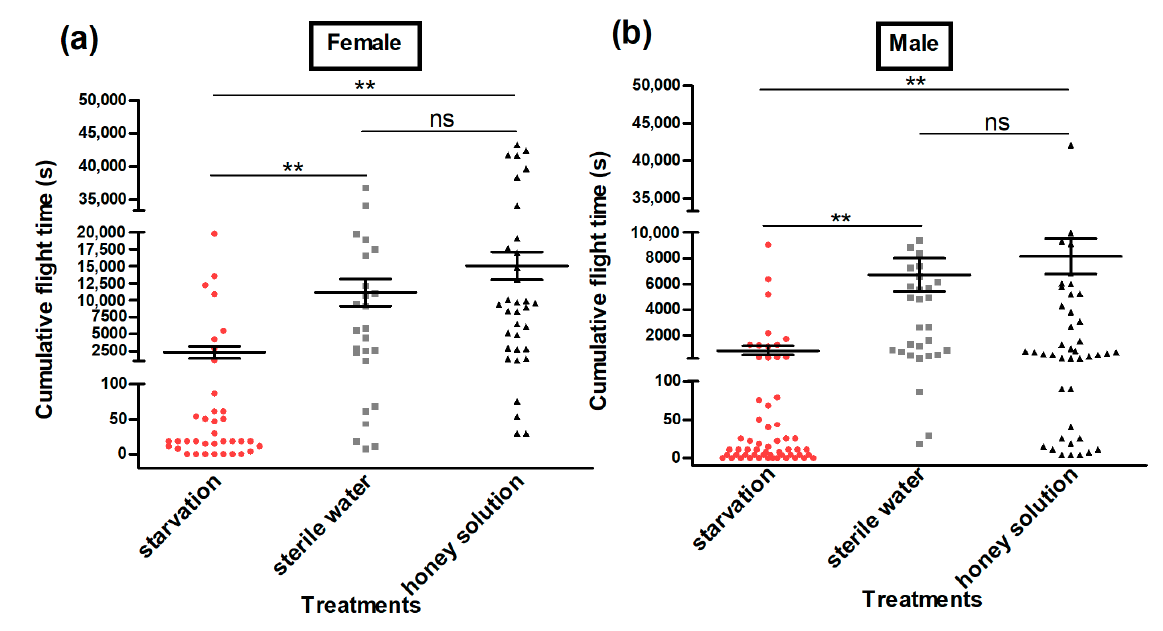
Figure 4. Cumulative flight time (s) of female ( a ) and male ( b ) Grapholita molesta moths under different feeding treatments. The data are shown as the mean ± standard error. **, significant difference at p < 0.01; ns, no significant difference.